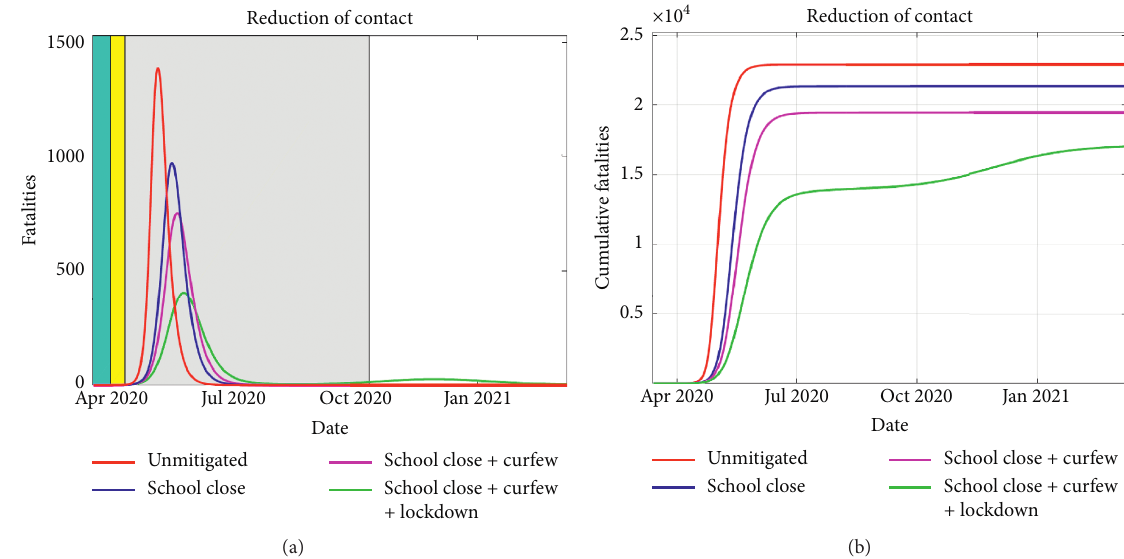
Figure 8: The simulated daily number of fatalities is shown in (a), where the duration of the NPIs is indicated by the colored region. The cumulative number of fatalities is presented in (b). In the event all three mitigation measures are in place, the cumulative cases “plateau” at a much lower